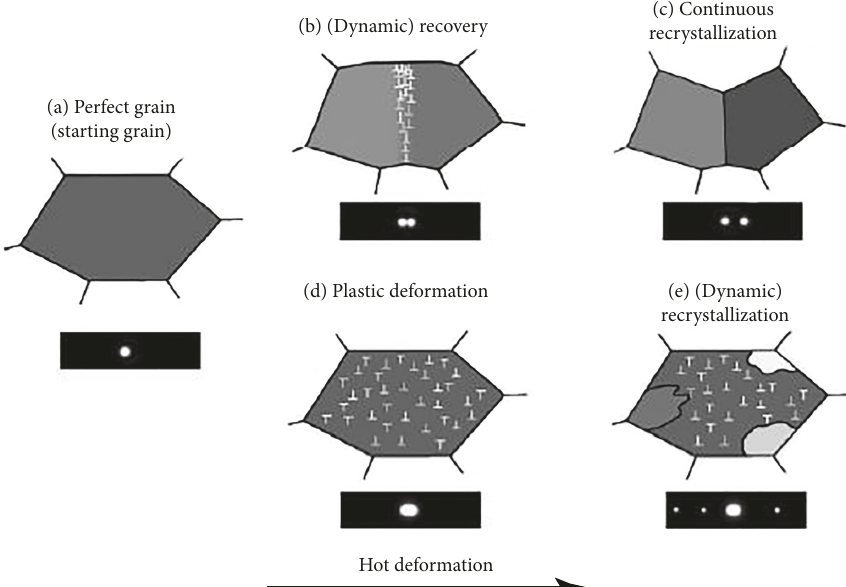
Figure 12: Schematic model that illustrates the development of reflection spots dependent on the different processes that might occur during hot deformation of TiAl alloys. Starting with a perfect grain, plastic deformation increases from left to right. The development of the corresponding reflection spot is indicated below. In (a), a sharp reflection spot of a perfect grain is visible. Images (b) and (c) show how dislocations are introduced by plastic deformation which forms a subgrain boundary in (b) through dynamic recovery processes and eventually a high-angle grain boundary in (c). In contrast to this, images (d) and (e) show a case where the defect density increases until the onset of recrystallisation which is illustrated by the nucleation of new grains (adopted from